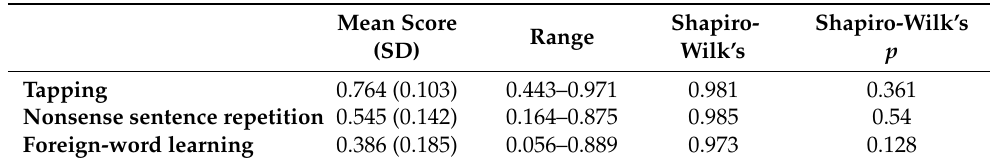
Table 1. Mean scores for tapping from memory (proportion of correct tap durations), for nonsense sentence repetition (proportion of words/pseudowords correct), for foreign-word recall on the fourth trial (proportion of syllables correct), and Shapiro–Wilk’s test of normality of the